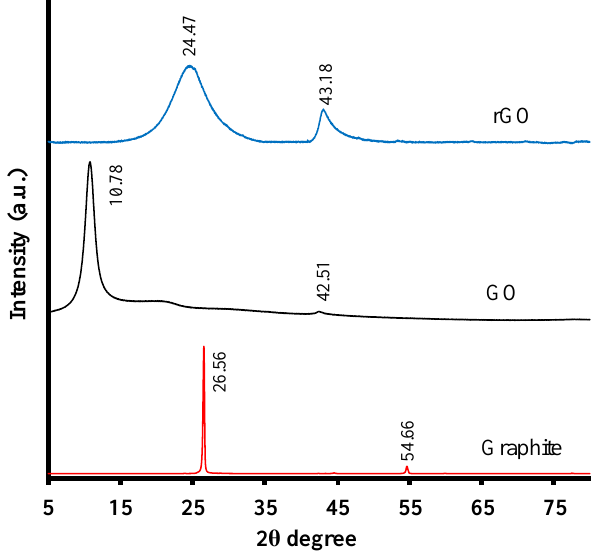
Figure 1. Thermogravimetric analysis curves for TiO 2 and x% rGO-TiO 2 .